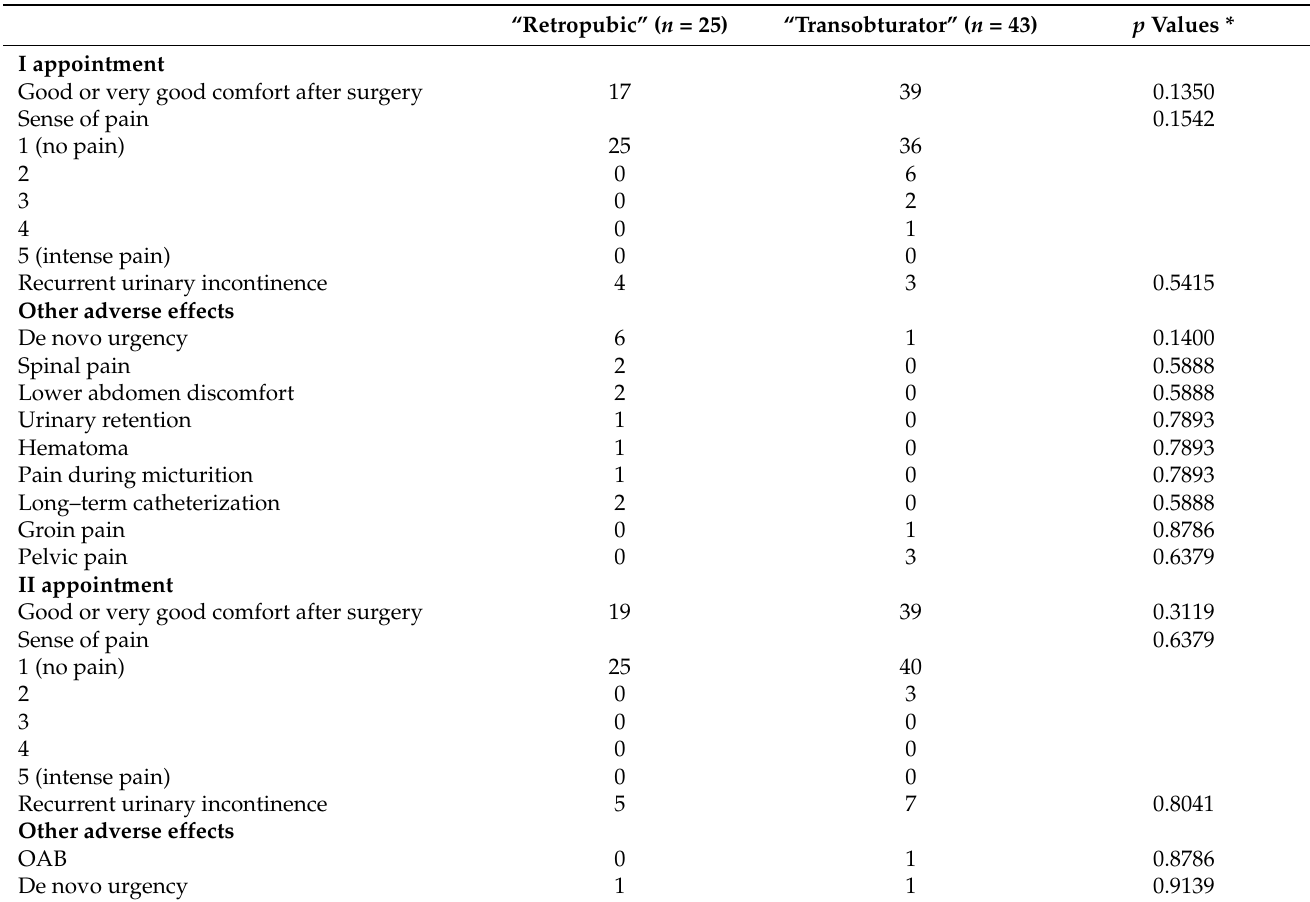
Table 3. Outcome measures at I appointment (<6 months after surgery) and II appointment (>6 months after